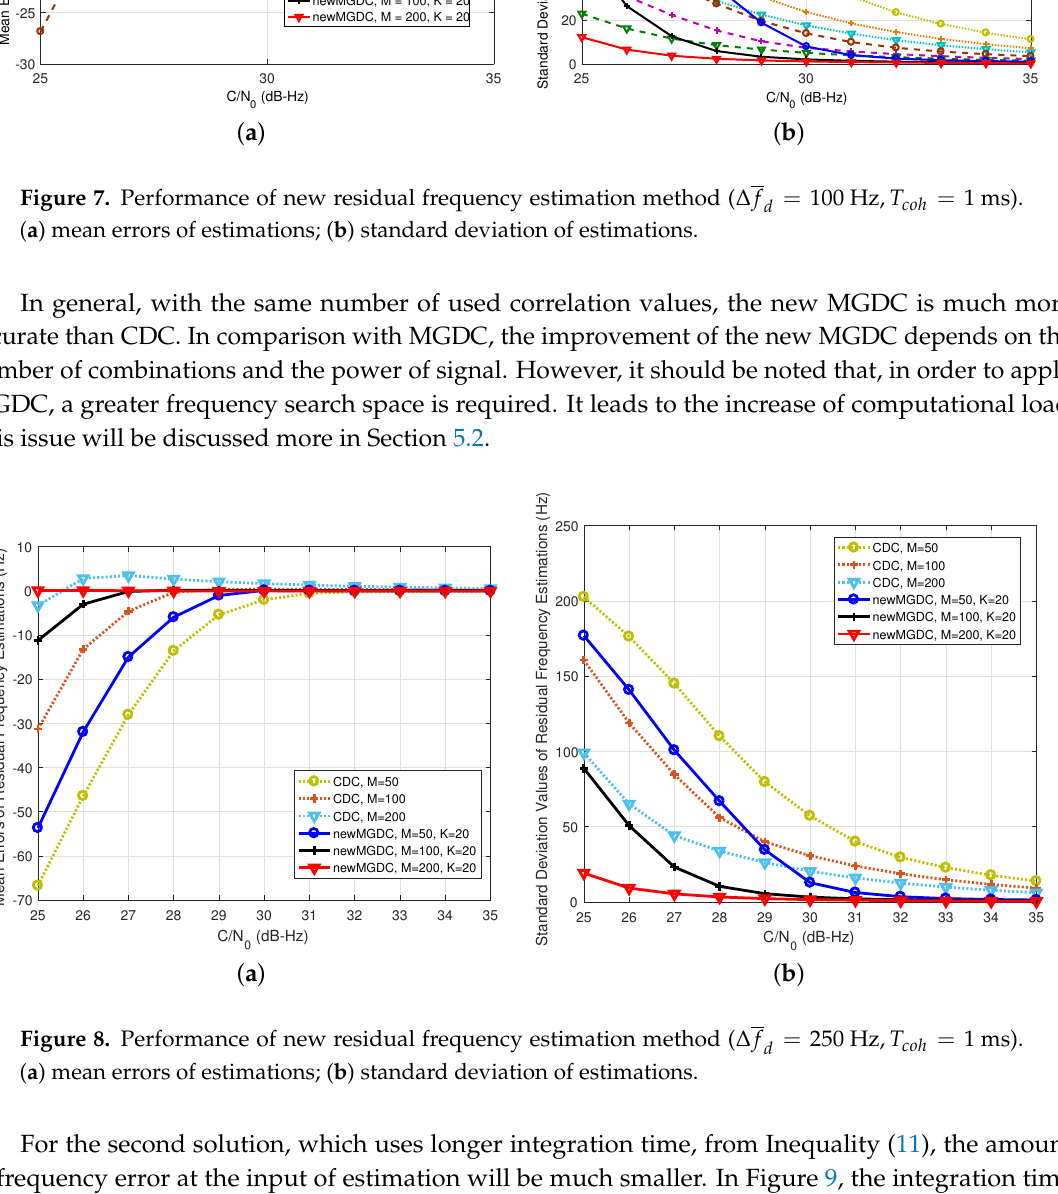
Figure 8. Performance of new residual frequency estimation method ( ∆ f ( a ) mean errors of estimations; ( b ) standard deviation of